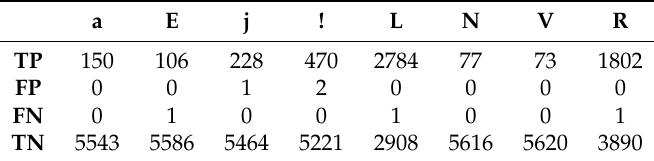
Table 12. Results of TP, TN, FP, and FN from confusion matrix of Table